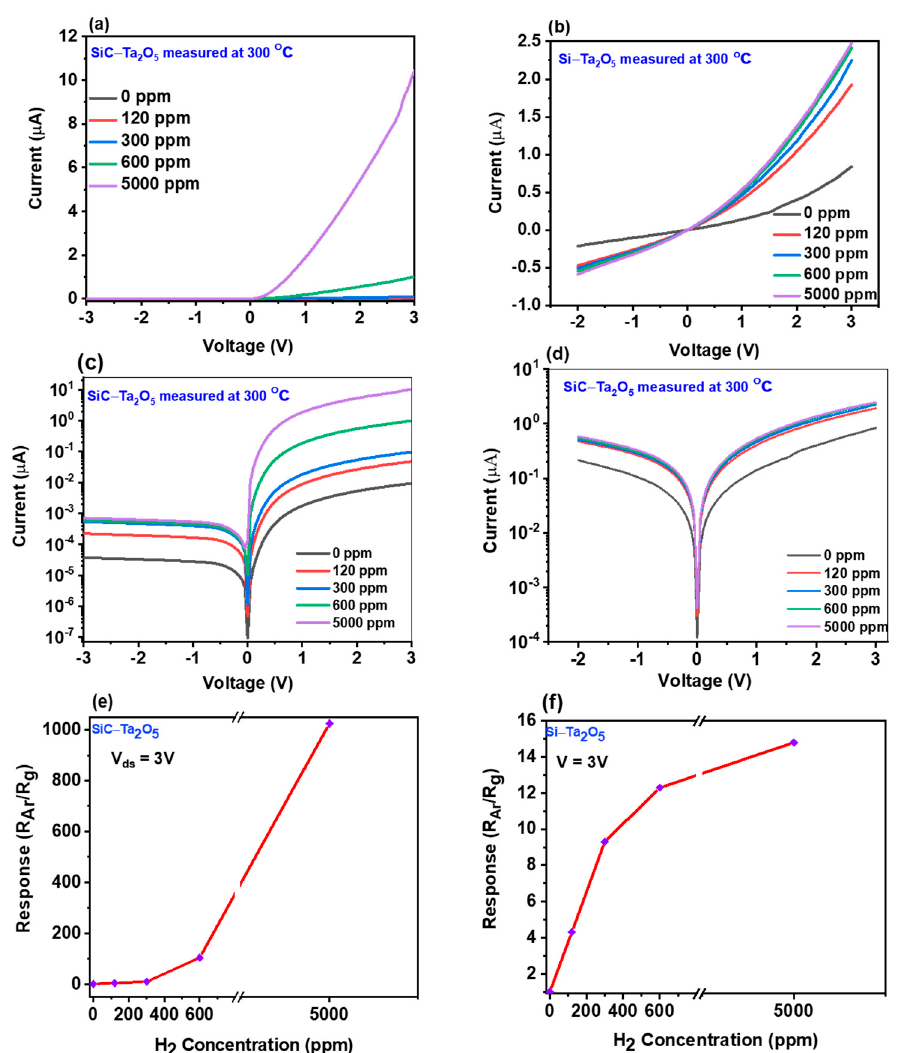
Figure 4. The rectifying diode characteristics of the Pd/Ta 2 O 5 Schottky diodes as H 2 sensors: ( a ) and ( b ) the typical linear I-V curves of the device on ( a ) the SiC substrate, and ( b ) the Si substrate, in the presence and absence of H 2 gas; ( c ) and ( d ) the corresponding logarithmic I-V curves; ( e ) and ( f ) the corresponding responses (R a /R g ) of the sensors as a function of H 2 concentration.